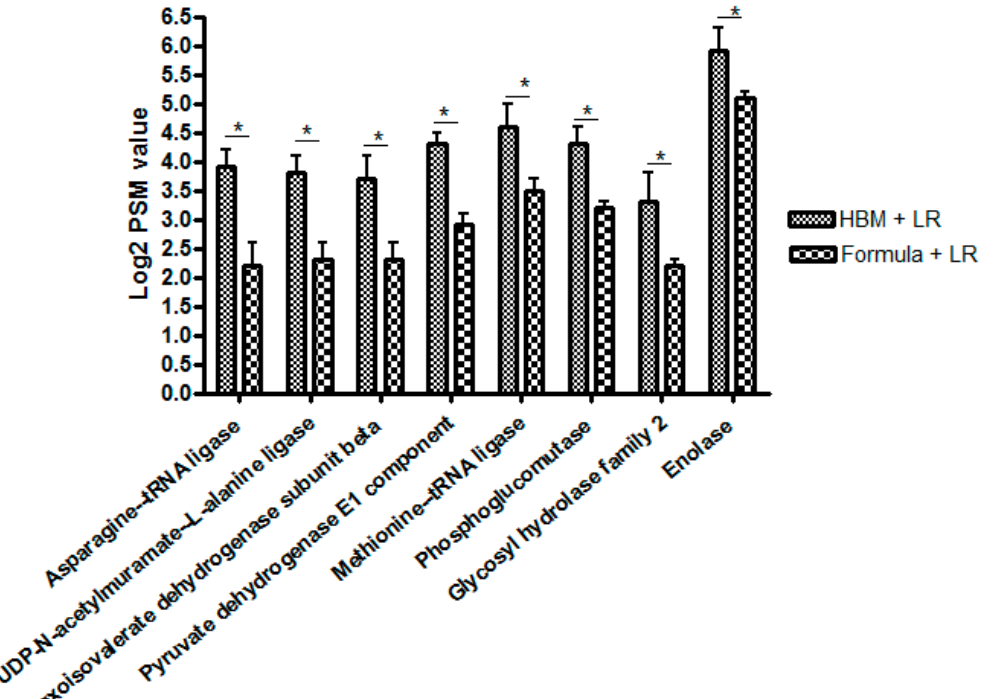
Figure 6. Proteomics data showing up-regulated proteins in HBM + LR group versus formula + LR group 2-oxoisovalerate dehydrogenase subunit beta, pyruvate dehydrogenase E1 component, and enolase are involved in acetyl CoA formation in glyoxylate cycle. Methionine-tRNA ligase is involved with cysteine formation (precursor to antioxidant glutathione). * All with p < 0.05.